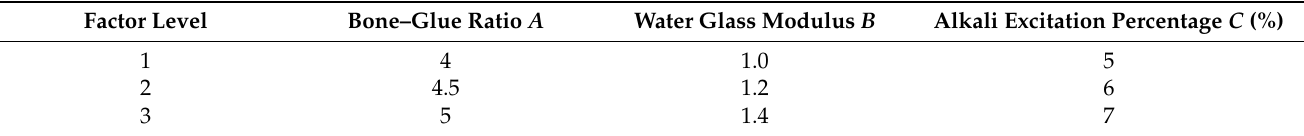
Table 3. Orthogonal test factor level table.